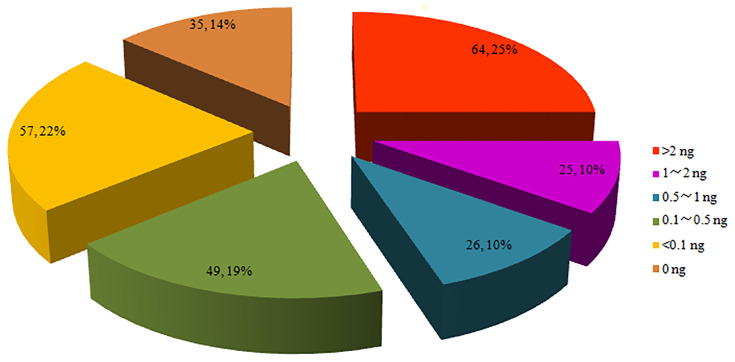
Proportion of parasite genomic DNA evaluated by 18s rRNA qPCR.